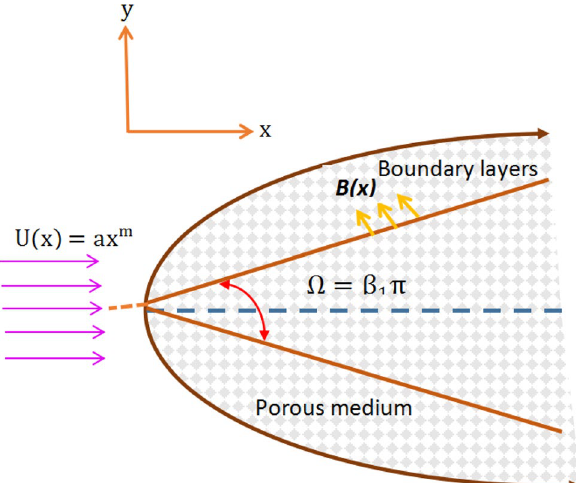
Figure 1. Geometrical illustration of the model.